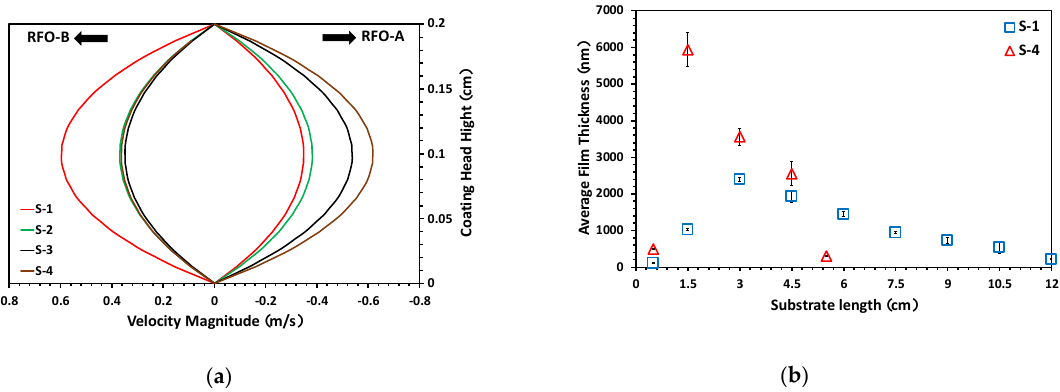
Figure 5. ( a ) Flow velocity profile (m/s) 8 mm in the front and behind the precursor injector slit for S-1 – S-4 configurations. ( b ) Mapping of CdTe film thickness profiles obtained in static mode for deposition conditions S-1 and S-4.